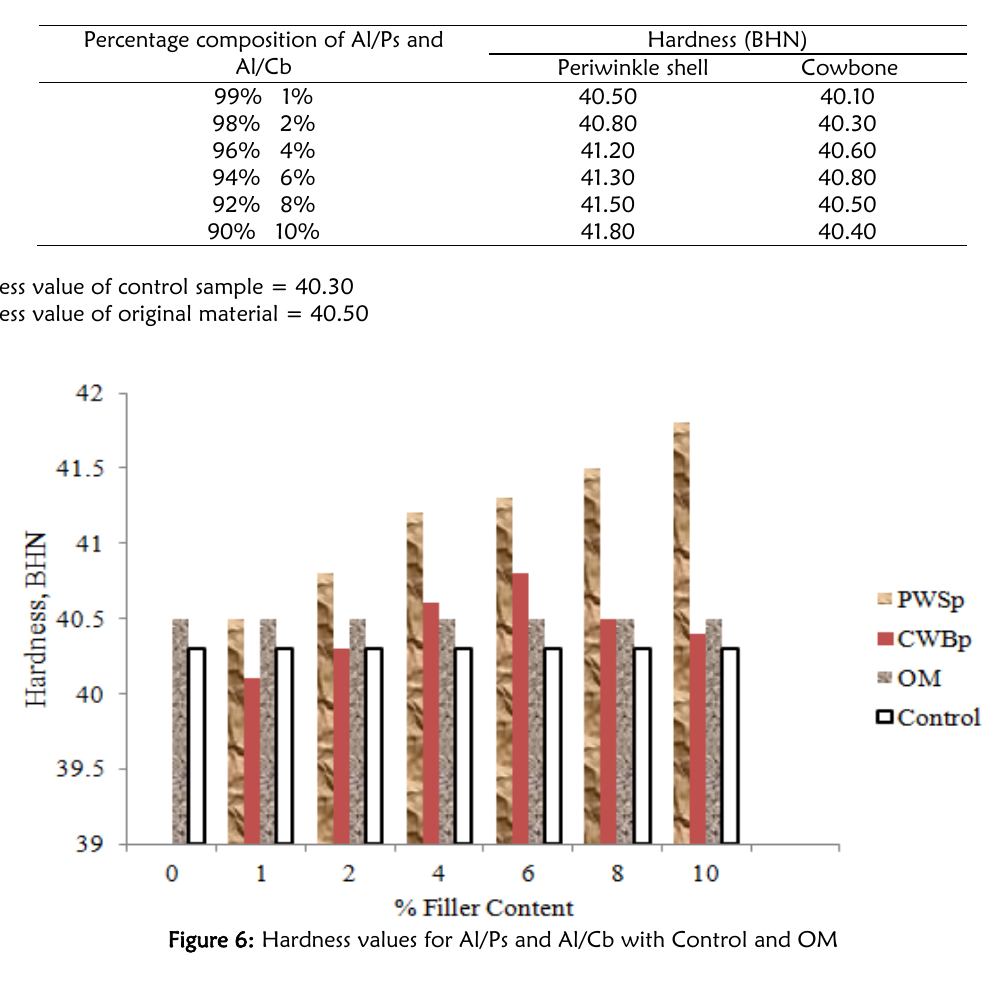
Table 4: Hardness values of Al-wt % Ps and Cb knee brace produced